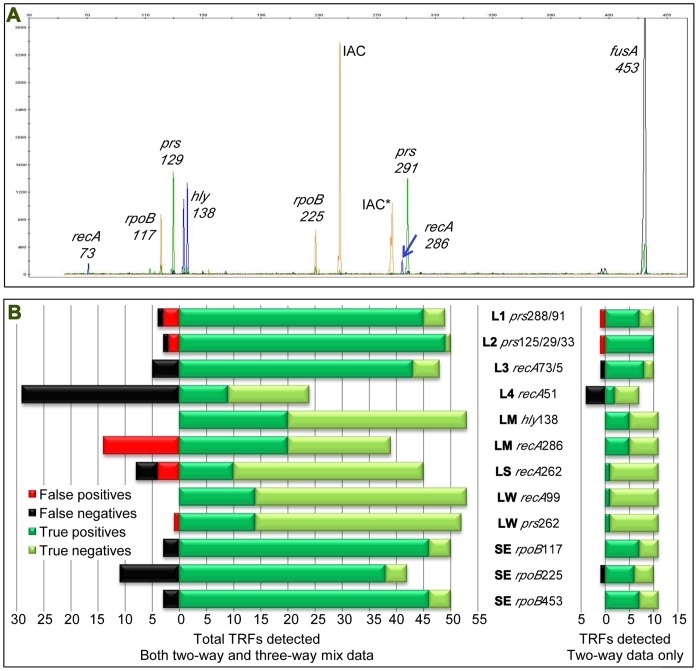
M-TRFLP profile and analysis of pre-amplification DNA template mixes.A: M-TRFLP profile of pre-enrichment mix of five strains of each of L. monocytogenes, S. enterica and E. coli, following Chelex extraction of DNA, multiplex PCR, post-PCR cleanup and HhaI restriction digestion. TRFs are labelled as the genes they represent and the sizes reported in base pairs, with rpoB and fusA TRFs S. enterica specific and TRFs from recA, hly and prs L. monocytogenes specific. Inocula were mixed in the ratio of 1∶1:10 in favour of Listeria, and DNA extracted from the sample post-enrichment using a Chelex-based procedure prior to PCR amplification and the products purified following PCR and prior to restriction digestion with HhaI. The TRF labelled IAC is the internal amplification control, and the IAC TRF with the asterisk undigested. B: TRF detection from two- and three-way pre-amplification template mix experiments. True and false positives and true and false negatives are indicated. Total specific TRF detection for all data is presented on the left and just two-way mix data on the right. The presence of bacteria specifically indicated by each TRF are coded as follows: SE, S. enterica; LG, L. grayi; LI, L. innocua; LV, L. ivanovii; LM, L. monocytogenes; LS, L. seeligeri; LW, L. welshimeri. *Indicates more than one target Listeria species is indicated by the presence of this TRF: L1 indicates the presence of LI, LM, LS, or LW; L2 indicates LG, LI, LV, LM, or LS; L3 indicates LI, LV, LM, or LW; L4 indicates LI, LV, or LS.